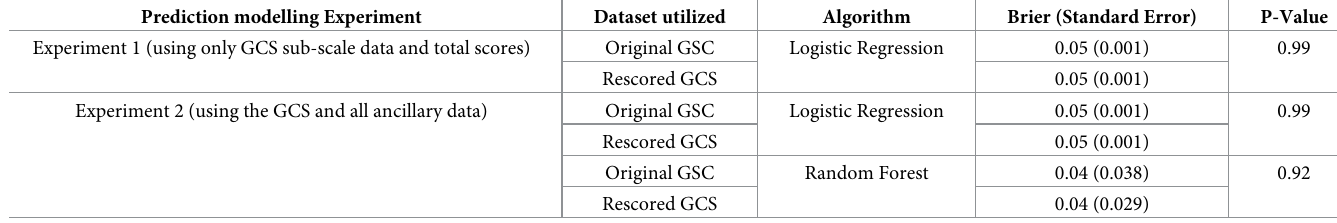
Table 5. Prediction modelling (Brier score) results using the original GCS sub-scale scores compared to the re-scored versions.